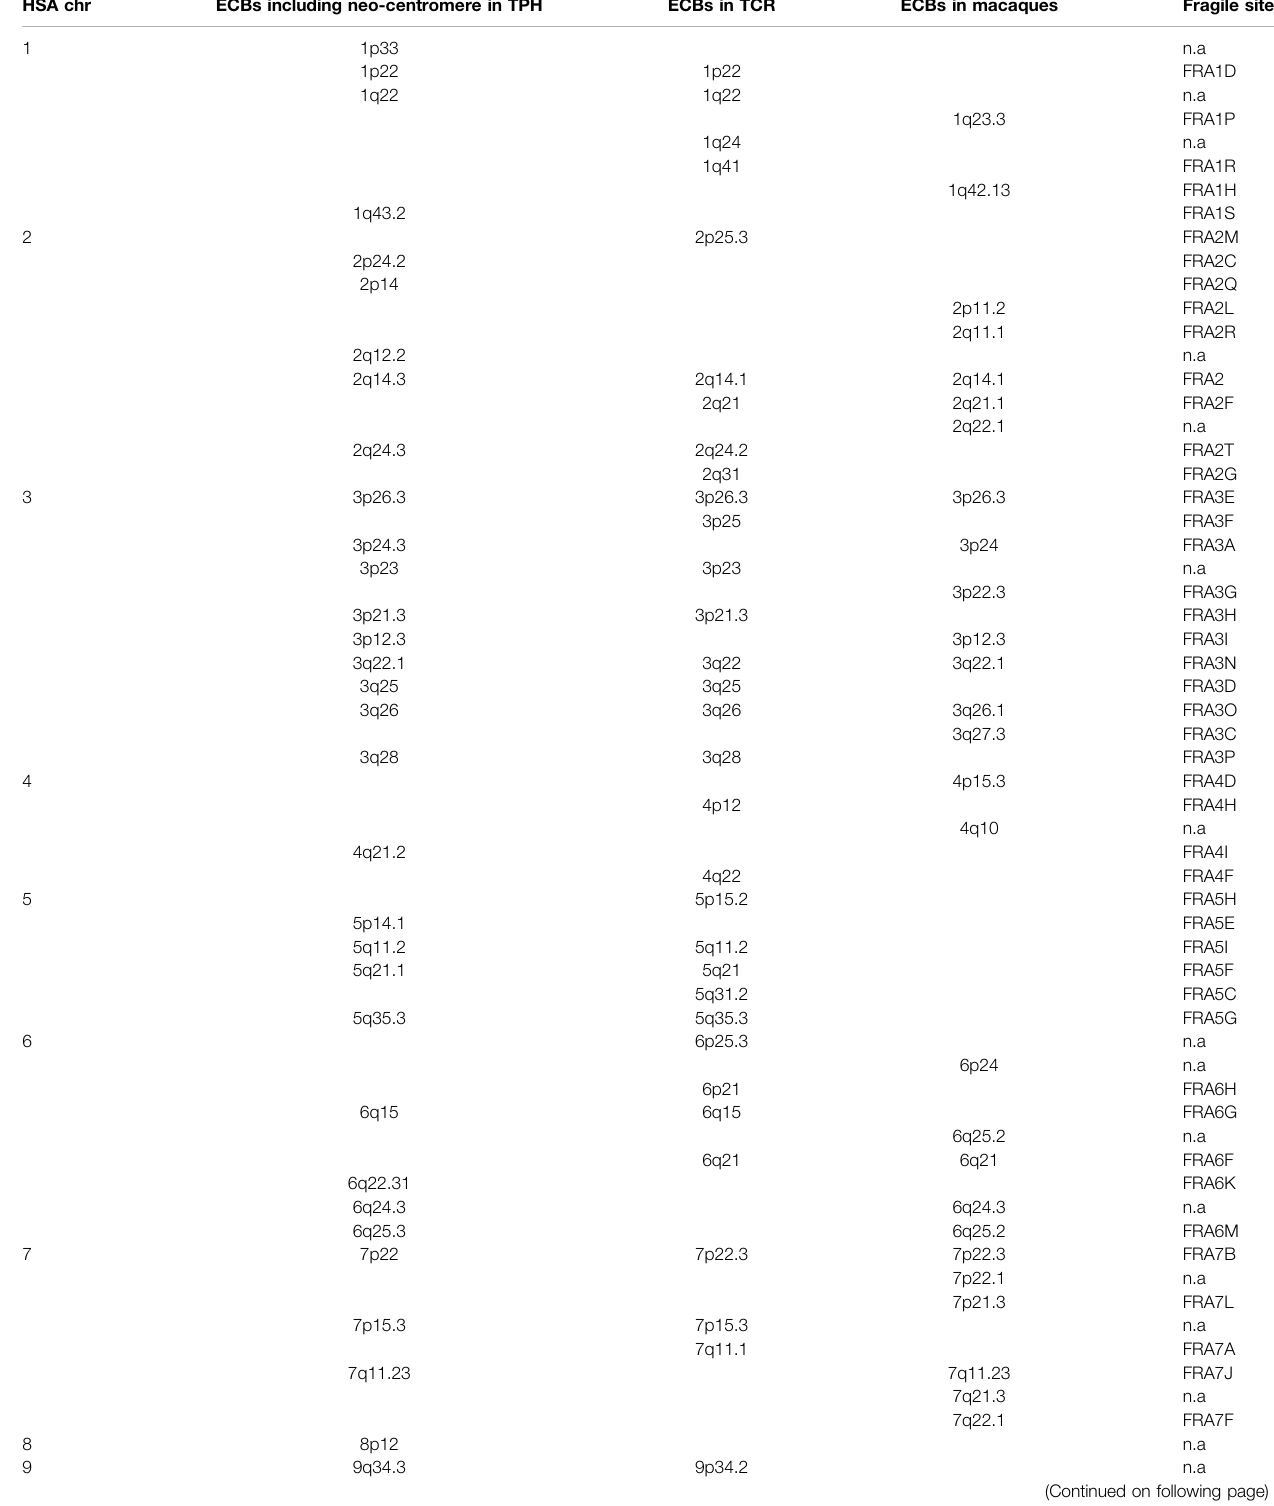
TABLE 2 | Colocalization of ECBs and FSs in TPH, TCR and Macaque species. Nomenclature and data acc. to (Xiaobo et al., 2013; Fan et al., 2014; Mrasek et al., 2010). HSA chr ECBs including neo-centromere in TPH ECBs in TCR ECBs in macaques Fragile